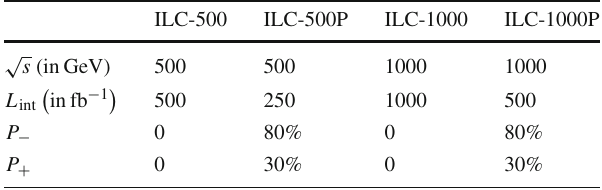
Table 1 Accelerator parameters for each of the run scenarios consid- ered in this paper. P − and P + represent the electron and positron